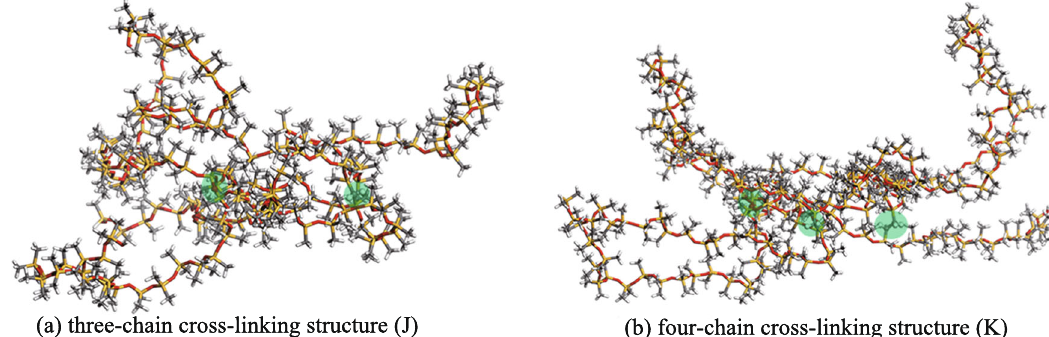
Fig. 16 The typical multiple-chain cross-linking structures of the aged PDMS chains. a three-chain cross-linking structure (J) including Si-O- Si and Si-C-Si links and b four-chain cross-linking structure (K) including Si – O – Si, Si – C – Si, and Si – C – C – Si